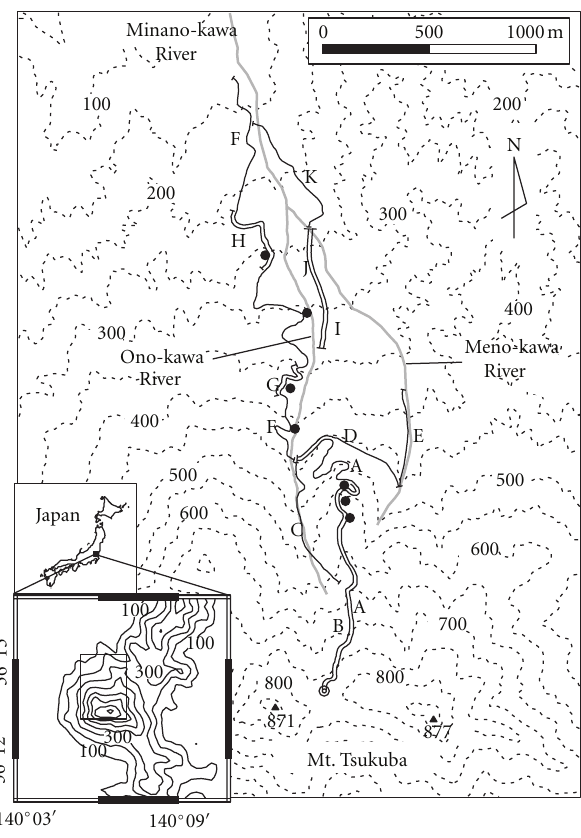
Figure 1: Location of Mt. Tsukuba and SP survey routes. Thick solid lines: the SP survey routes. A double circle: reference point for SP measurement. Solid circles: locations of DC resistivity survey. Thin solid lines: equi-topographic contour. Gray lines: rivers.